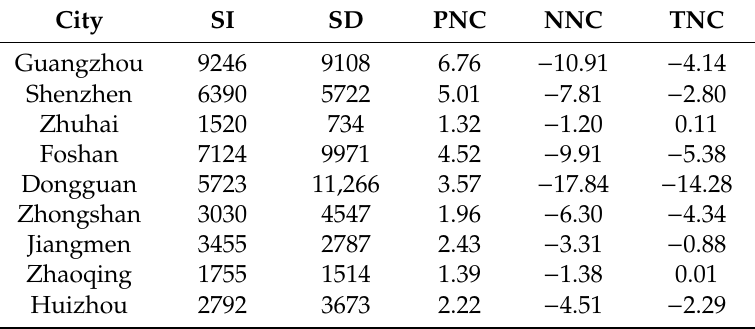
Table 2. Number of pixels of SI and SD; PNC, NNC, and TNC of vegetation change in urban land of the